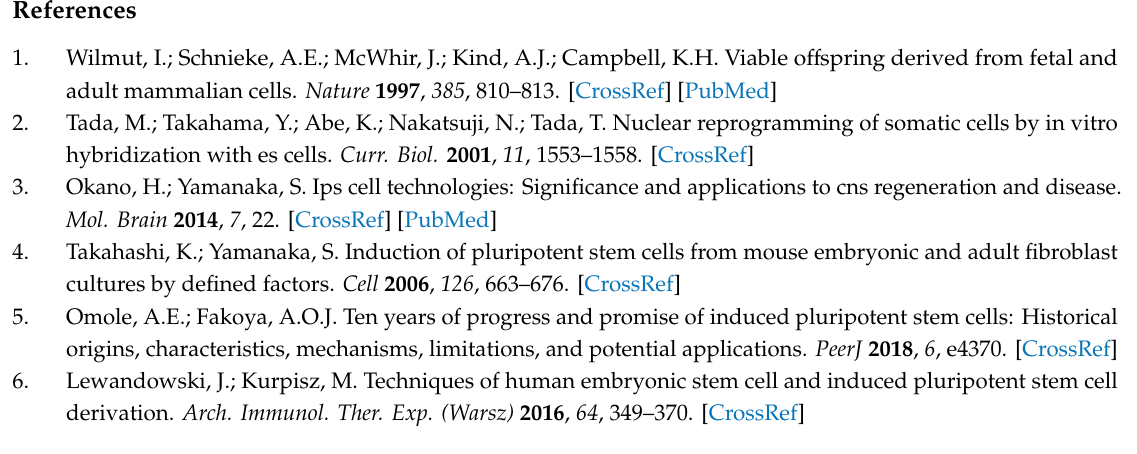
figure; C.M.C.: manuscript preparation; L.A.A.: manuscript review and figure preparation; A.H.-P.: manuscript and figure preparation and review. All authors have read and agreed to the published version of the